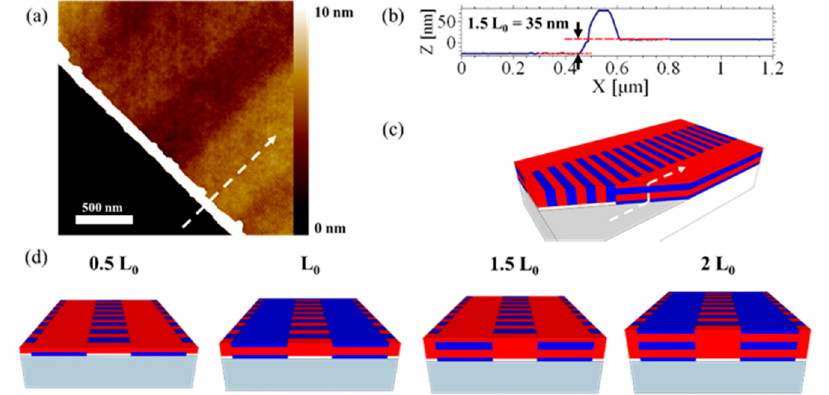
Figure A3. Measuring the height step between substrate and horizontally aligned block copolymer lamellae. ( a ) AFM height image of prepared sample; ( b ) single line profile indicated by white dashed line in ( a ); ( c ) 3D sketch of the measurement presented in ( a ); ( d ) possible self-assembly morphologies with height quantized to from 0.5 L 0 –2 L 0 in steps of 0.5 L 0 .